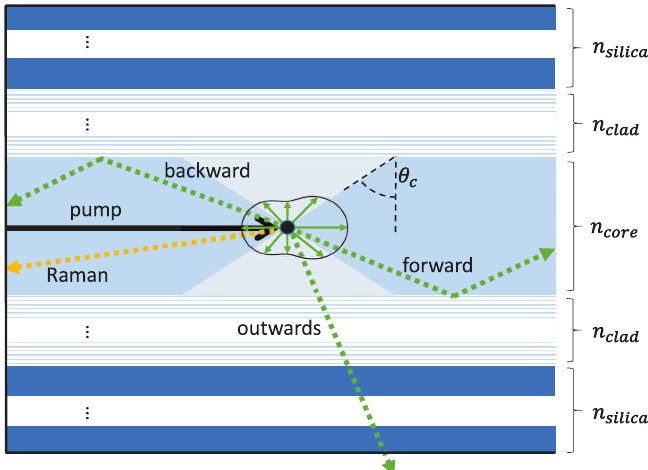
Figure 4. Schematic drawing of the scattering process on a nanoparticle inside a fiber. Laser light (pump) is coupled into the fiber from the left side and scattered on a nanoparticle. For illustrative purposes, a spatial distribution of the scattering angles for Mie-scattering on nanoparticles is shown. Light scattered under an angle larger than the critical angle θ c with respect to the cladding is guided inside the core (forward and backward). For angles smaller than the critical angle, the light is not guided within the fiber core and scattered outwards. Only Raman-scattered light in the backward direction contributes to the signal. For illustrative purposes, only a single nanoparticle is shown. The correct proportions of the cladding and holey region are shown in Figure